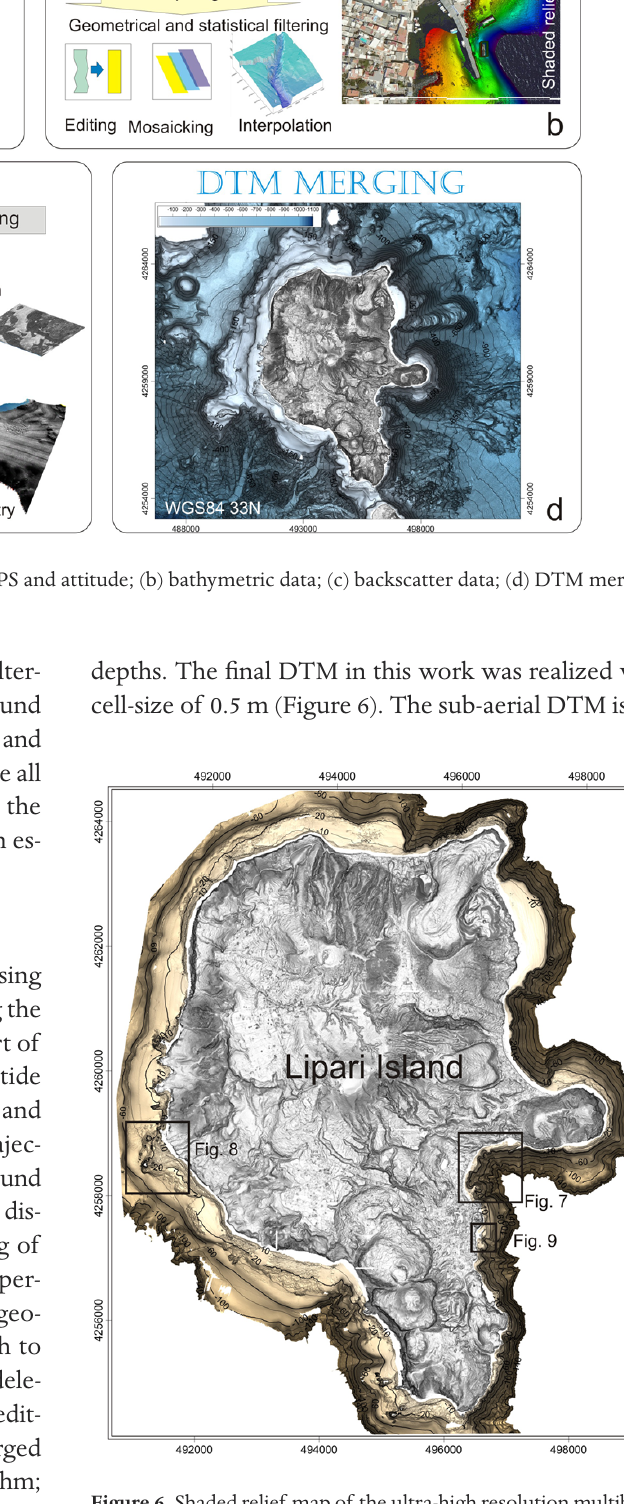
Figure 6. Shaded relief map of the ultra-high resolution multibeam bathymetry acquired during our surveys with the location of the areas (black squares) discussed in the text and in Figures 7, 8 and 9. Projection UTM 33N, Datum